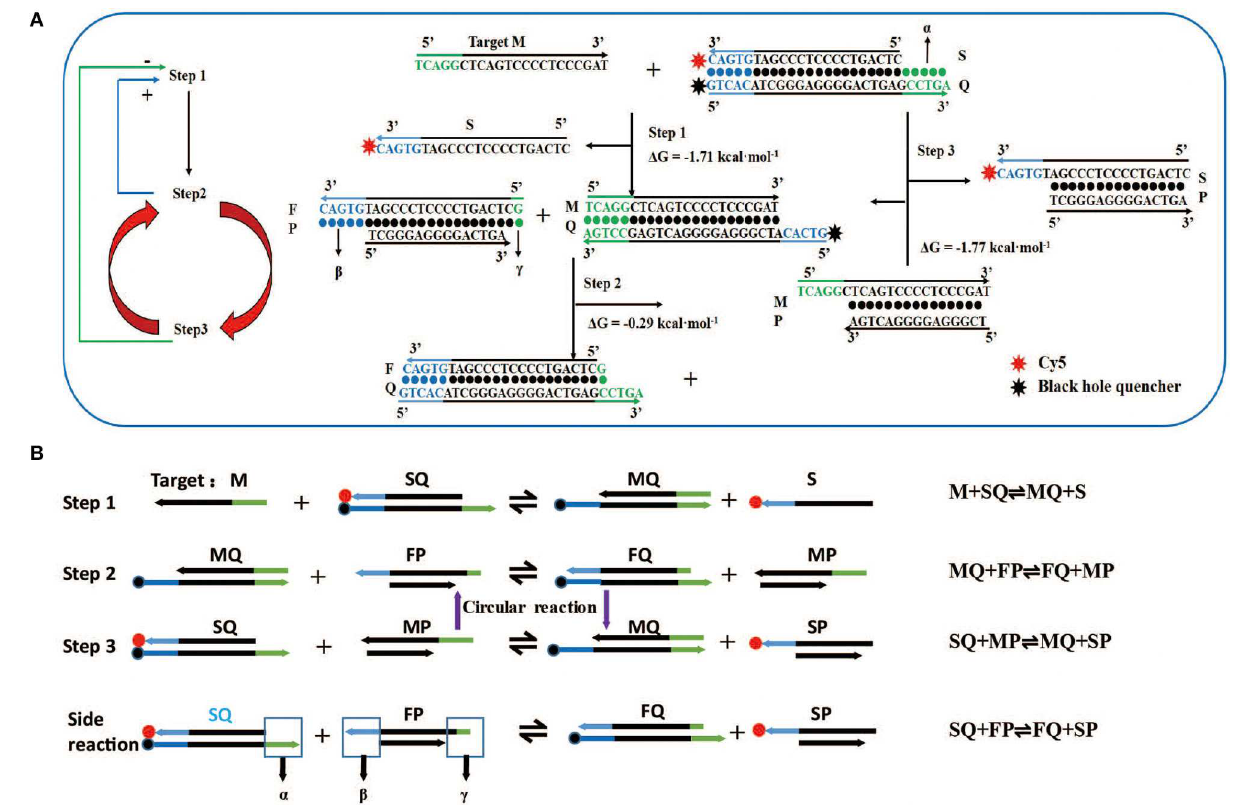
FIGURE 1 | Design and reaction mechanism of artificial intelligent signal amplification (AISA) detection system. (A) Left panel: logical diagram of the three-step reaction, the second reaction and the third reaction occur in cycles, “ + ”: positive feedback, the second step reaction can promote the occurrence of the first step, “–”: negative feedback, the third step reaction has a negative feedback effect on the first step; right panel: schematic diagram of the reaction between two double-stranded DNAs (SQ and FP) in the artificial intelligence molecular amplification (AISA) system with target miRNA (e.g., Hsa-miR-484). The arrowheads point to the products and the reactants are on the other sides. The three reactions described in (A) correspond to the three reactions in (B) . (B) The step reaction diagram and reaction equation between AISA system and the target M.